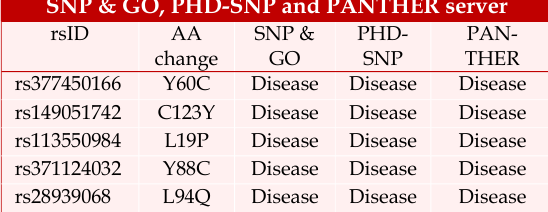
List of nsSNP predicted as disease associated by PANTHER server